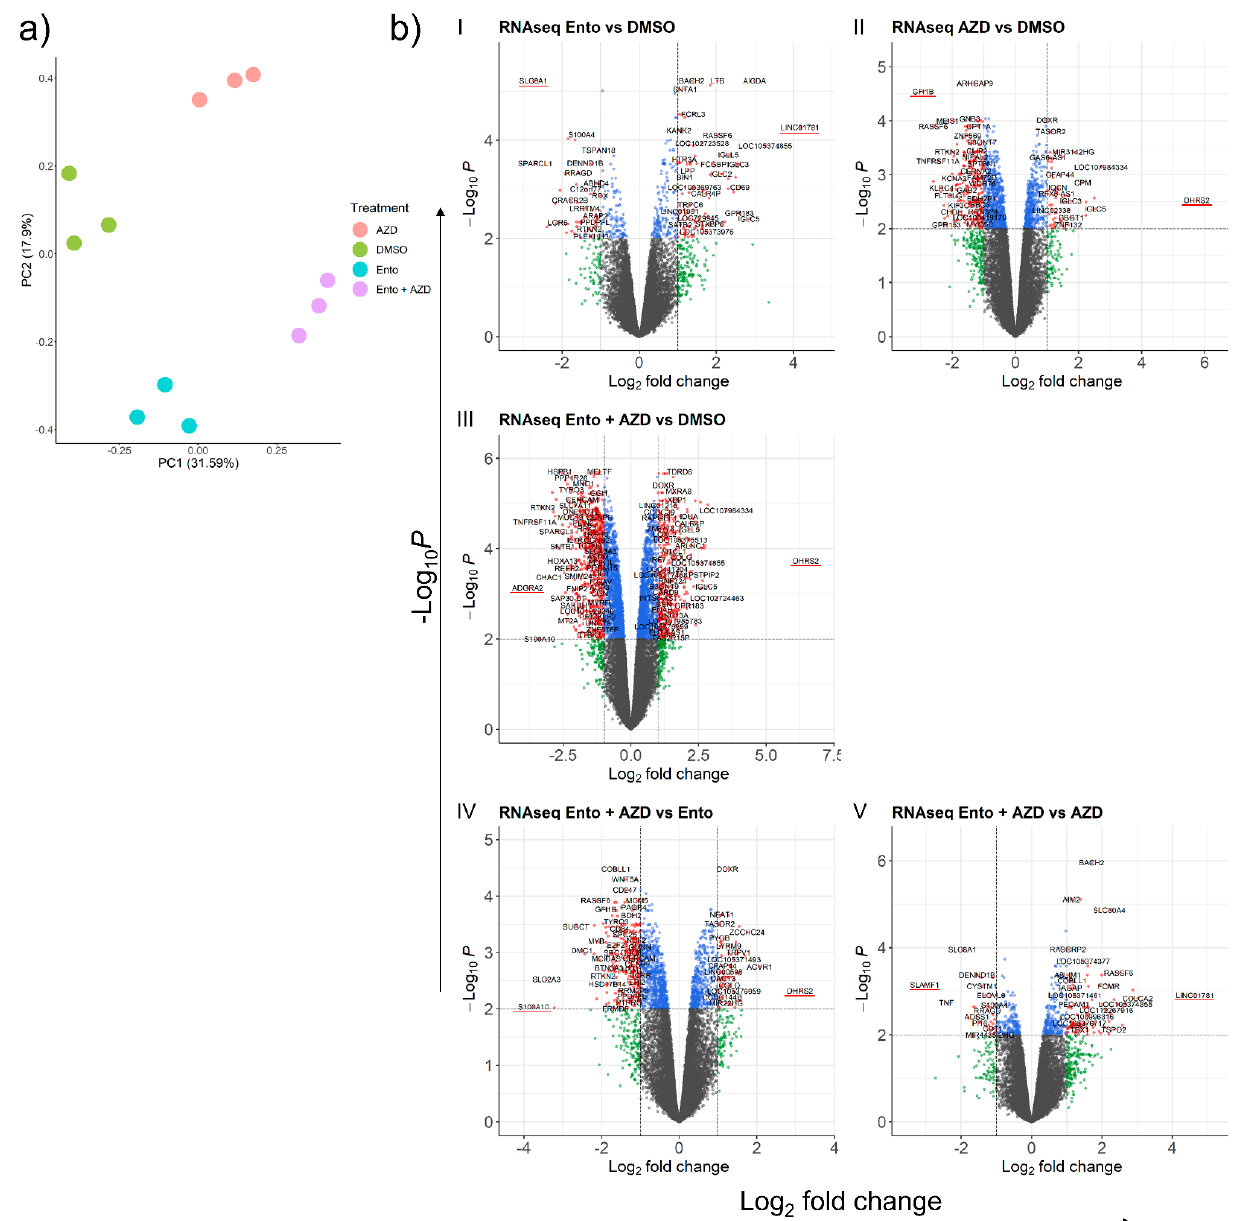
Figure 5. Gene expression modulation in SU-DHL-4 identified by RNAseq. Intensification of gene expression modulation by combined Ento+AZD exposure ( a ) PCA plot of the normalized RNAseq data (logCPM), showing the distinct clustering of the exposure groups in SU-DHL-4 cells ( b ) Volcano plots of the differential expression analysis of the RNAseq dataset for ( I ) Ento vs. DMSO, ( II ) AZD vs. DMSO, ( III ) Ento+AZD vs. DMSO, ( IV ) Ento+AZD vs. Ento and ( V ) Ento+AZD vs. AZD. Highest ranked DEG (overexpressed and underexpressed) is underlined (red) (n = 3).